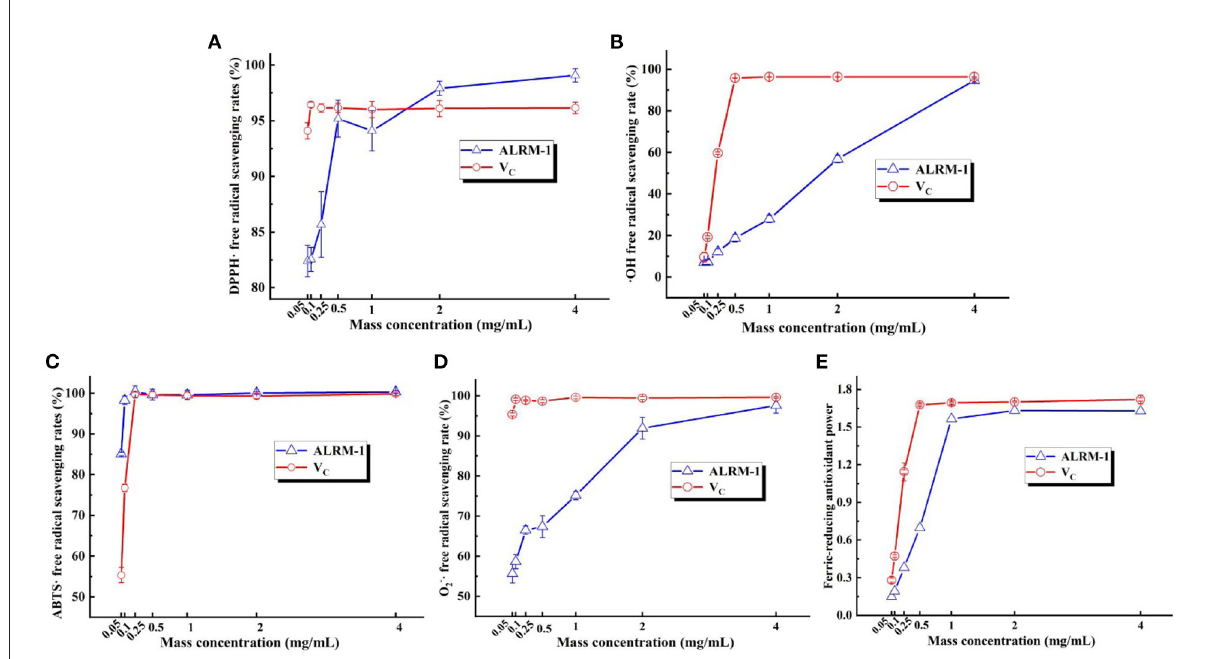
FIGURE9 The scavenging radical capacity of ALRM-1 [ (A) comparison of the scavenging rate of DPPH · radicals by V C and ALRM-1; (B) comparison of the scavenging rate of · OH radicals by V C and ALRM-1; (C) comparison of the scavenging rate of ABTS · radicals by V C and ALRM-1; (D) comparison of the scavenging rate of O − 2 · radicals by V C and ALRM-1; (E) comparison of FRAP by V C and ALRM-1].